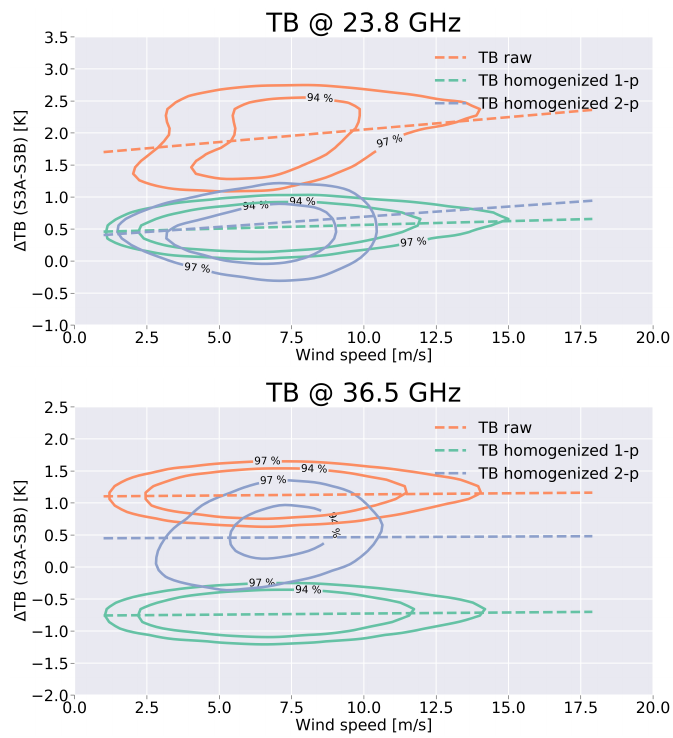
Figure 6. Density contour of the variation of the difference between S3-A and S3-B T B with the wind speed. Orange contours refer to the baseline T B , light green contours refer to the homogenized h-1p T B and the blue contours refer to the homogenized h-2p T B